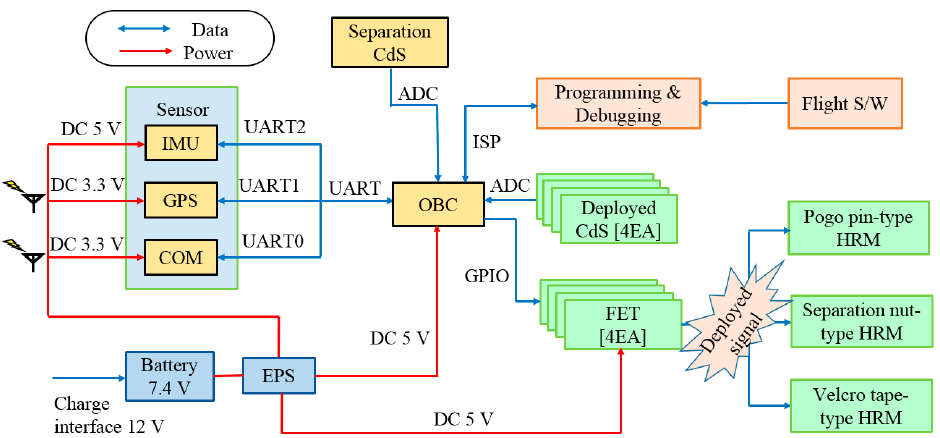
Figure 2. Block diagram of the electrical system of the DHRM